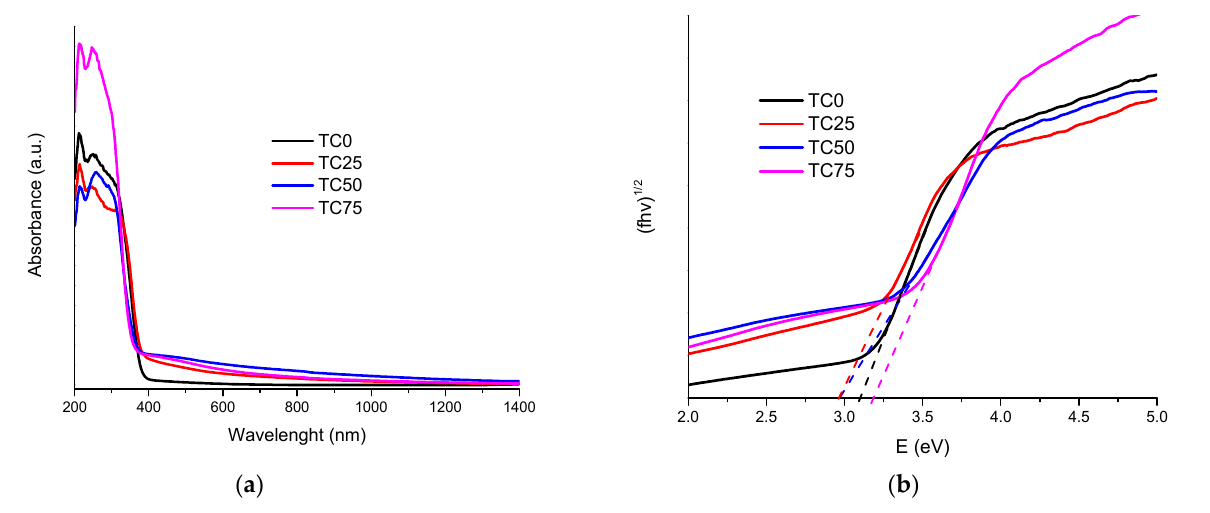
Figure 7. ( a ) UV-Vis/NIR diffuse reflectance spectra and ( b ) Tauc plots for TiO 2 (TC0), TC25, TC50 and TC75 photocatalysts.